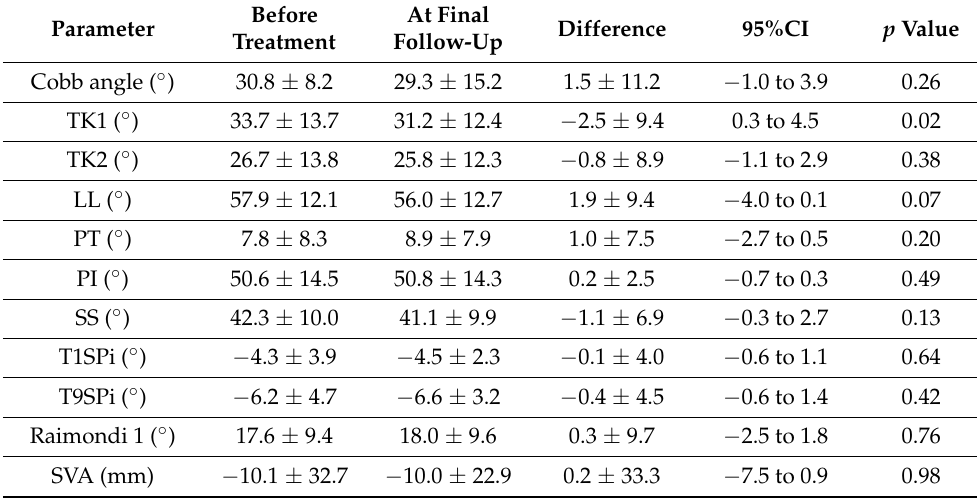
Table 1. Pre-brace to post-therapy changes of coronal and sagittal parameters regardless of the curve type.